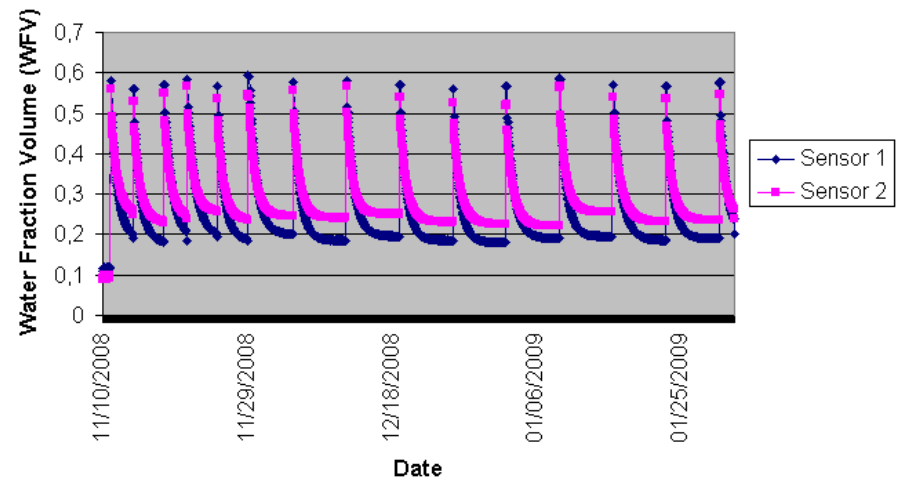
Figure 8. Humidity data from one of the